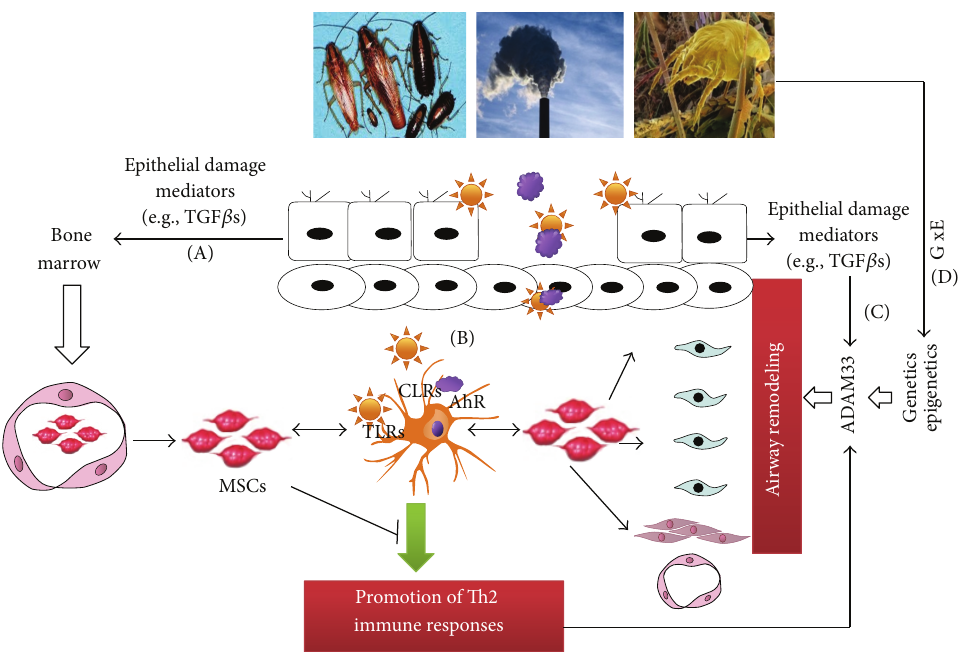
Figure 4: Schematic representation of possible mechanisms for ADAM33 in airway